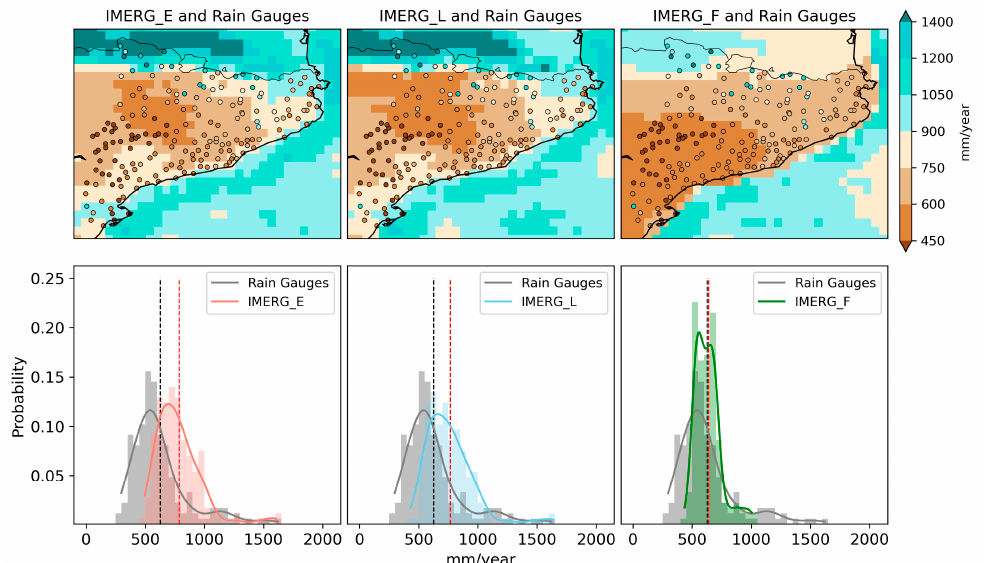
Figure 4. ( Top panel ) Mean annual precipitation accumulations of IMERG products and XEMA stations, in the period of 2015–2020. ( Bottom panel ) KDE curve associated with the distribution of each dataset, the black (red) dashed line represents the mean of the XEMA observations (IMERG). According to rain gauge data, the average annual rainfall in Catalonia during this period varies between 300 mm and 1600 mm/year. The lowest records are observed in the Central Depression, where they do not exceed 450 mm/year, followed by the coastal areas with values around 600 mm/year. In contrast, stations close to the Pyrenees have accumulations usually exceeding 900 mm/year and those located above 2000 masl typically are over 1600 mm/year, which represents the maximum values for the region under study, and also some of the highest of the Iberian Peninsula. This high spatial variability is consistent with previous precipitation climatologies [61–63] in the studied region, which guarantees the representativeness of the selected sample.